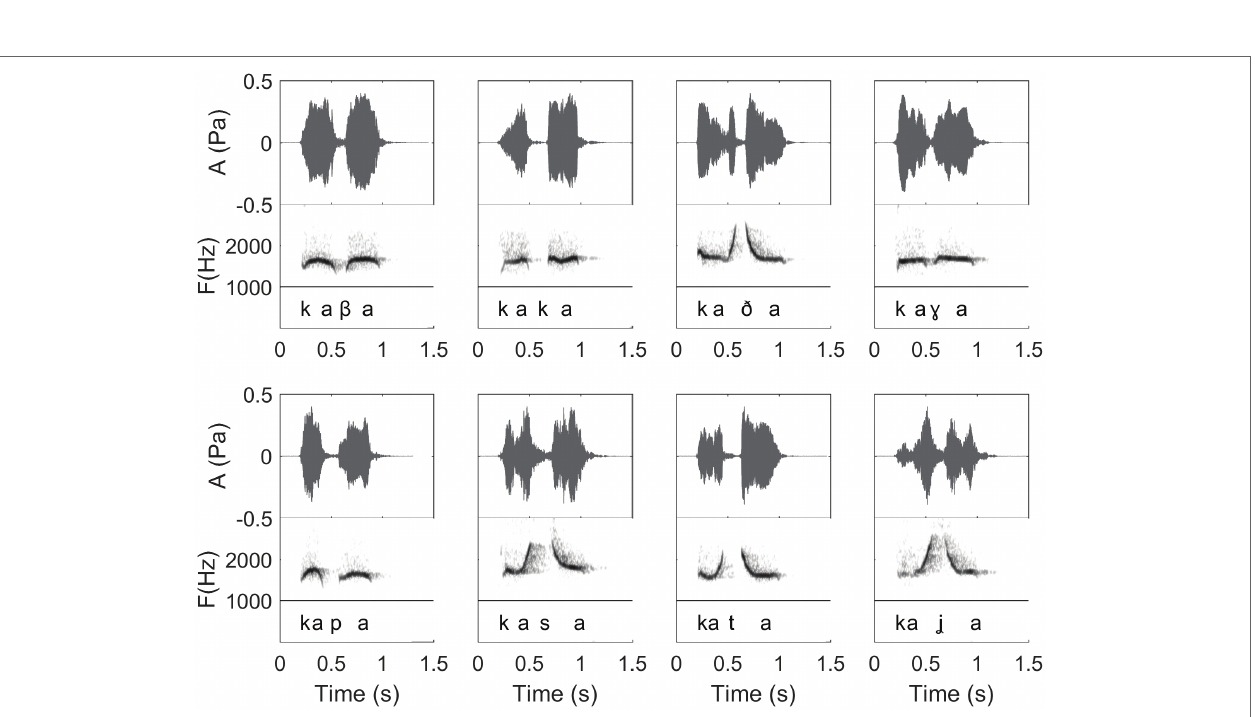
FIGURE 10 | Waveforms and spectrograms of 8 different Spanish words in their whistled form, with the phonetic transcription corresponding to how words were pronounced in spoken speech (International Phonetic Alphabet). From left to right, beginning in the upper line, words are as follows in Spanish orthography: “caba,” “caca,” “cada,” “caga,” “capa,” “casa,” “cata,” and “calla.” This figure shows how the 8 different consonants are encoded differently in whistled speech, resulting in a fine combination of amplitude and frequency modulations defining different frequency profiles: continuity profiles between the two vowels, steepness of the attack of the consonants, and consonantal gap duration in the amplitude envelope. (Recordings and edition by Julien Meyer, listen to sound extracts in Meyer and Diaz, 2021).